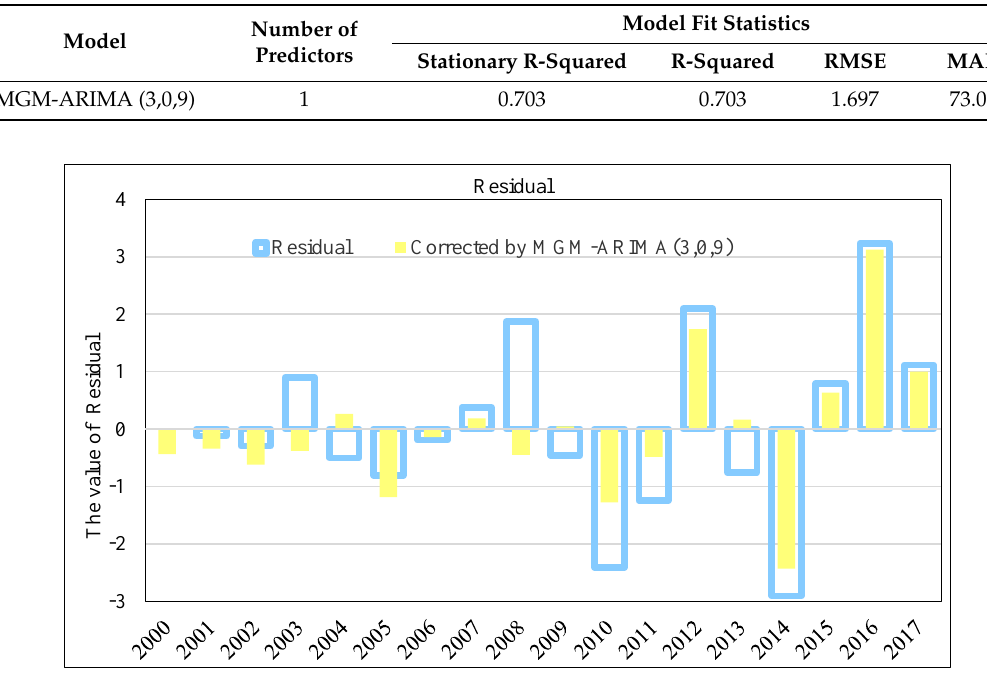
Figure 6. Comparison between the residual of MGM fitting results and the corrected residual.